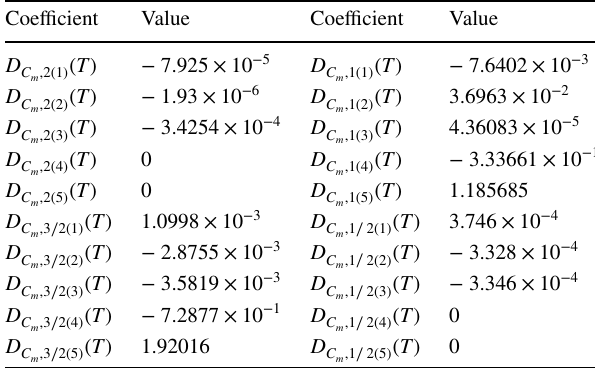
(Eq. (14)) at reference